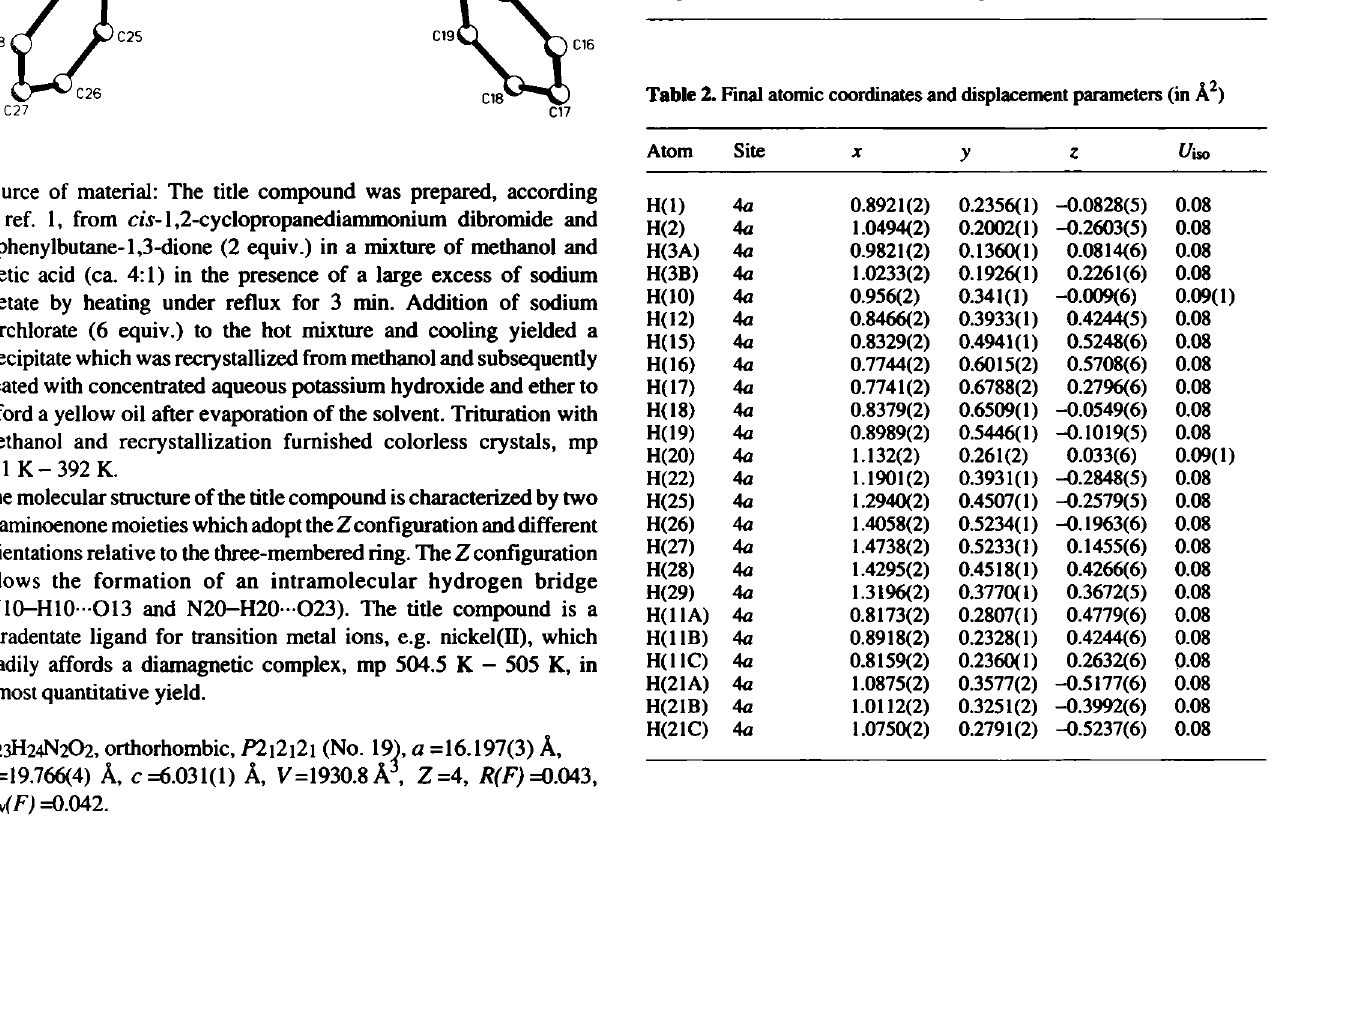
Table 2. Final atomic coordinates and displacement parameters (in